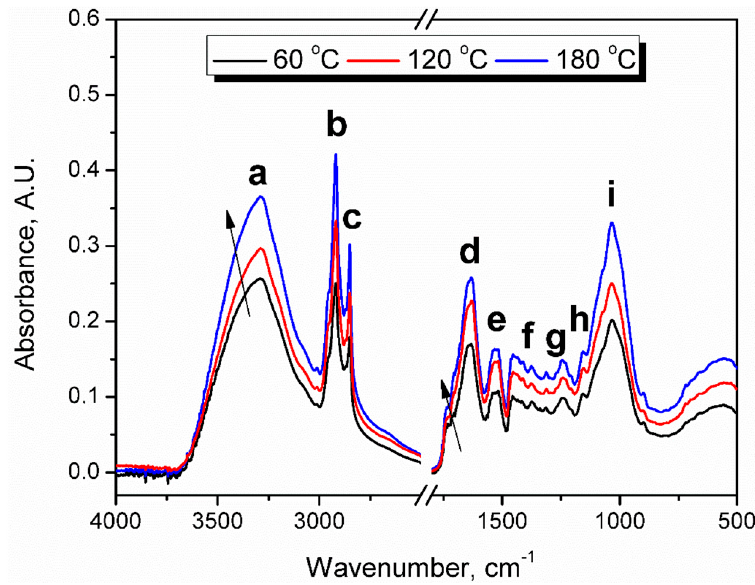
Figure 5. Fourier transform infrared (FTIR) spectra of extruded BSG.